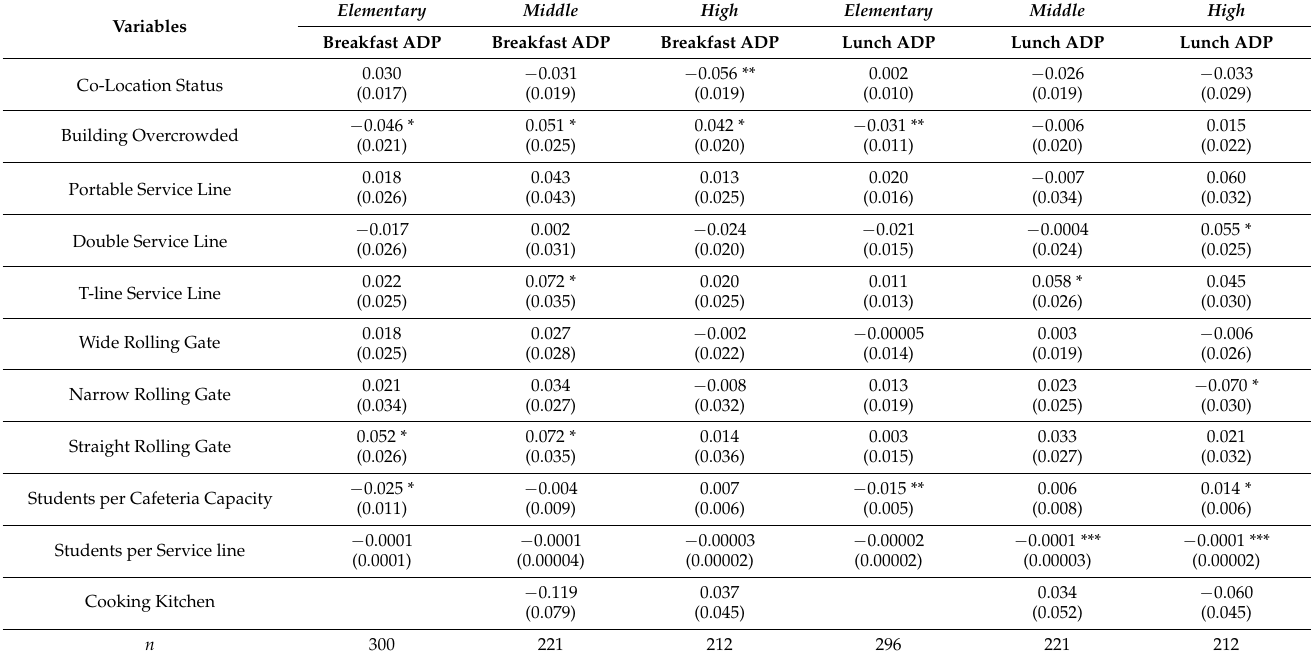
Table 2. Multivariate Beta Regression Results (Average Marginal Effects) for Percent Breakfast and Lunch Average Daily Participation (ADP) by School Level in New York City Public Schools.